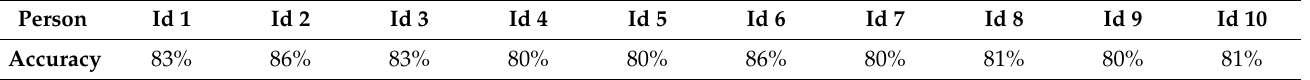
Table 1. Accuracy of routine detected by our genetic algorithm.